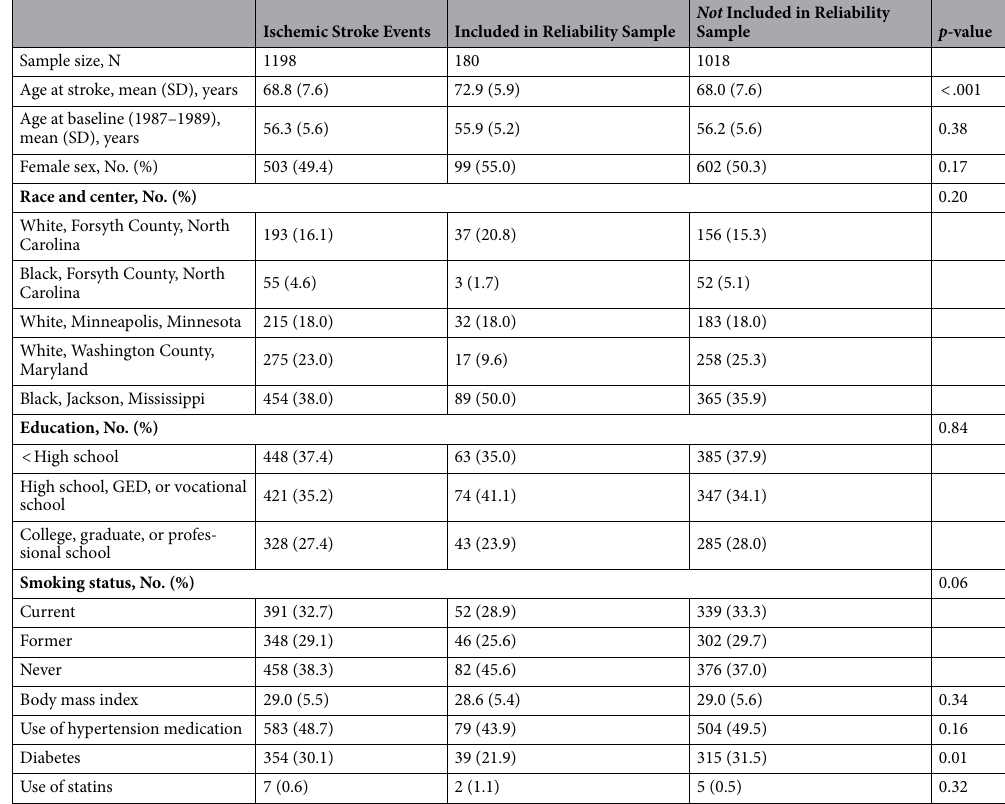
Table 1. Baseline characteristics of ARIC participants with ischemic stroke, overall and by inclusion in the inter-rater reliability assessment.